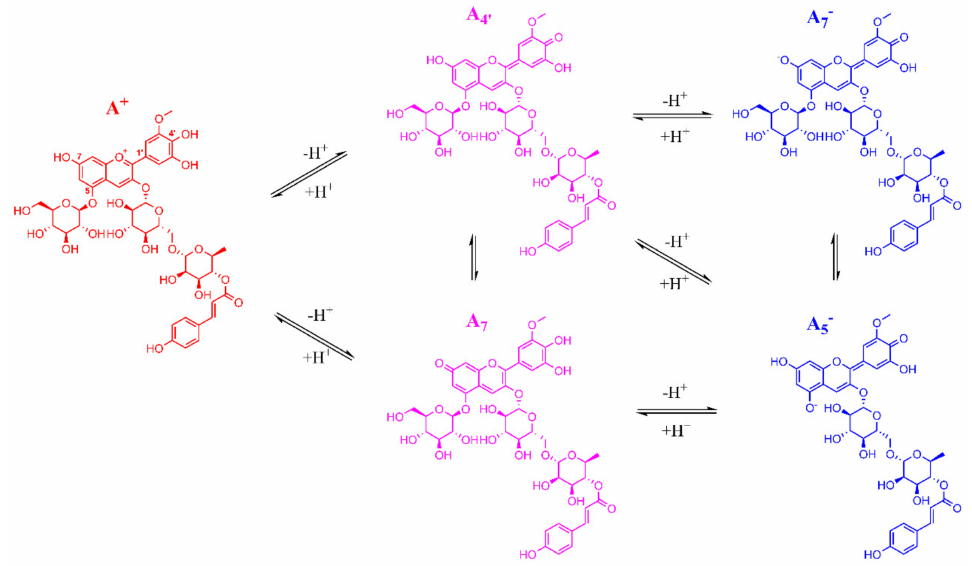
Figure A6. Visual display and quantitative values of the blue contribution of anthocyanin complex.